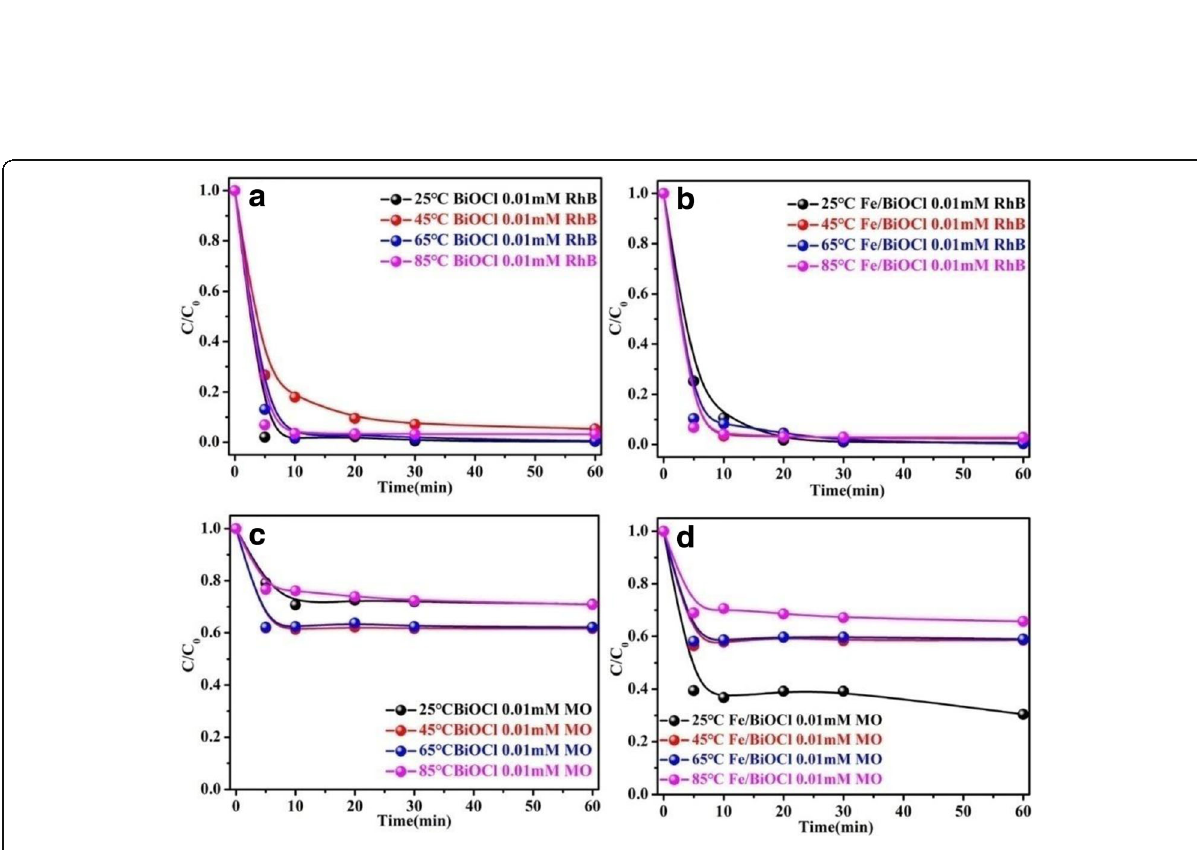
Fig. 7 Effect of initial concentration on adsorption capacities of BiOCl and Fe/BiOCl toward RhB ( a , b ) and MO ( c , d ) (pH = 7, temperature = 25 °C)